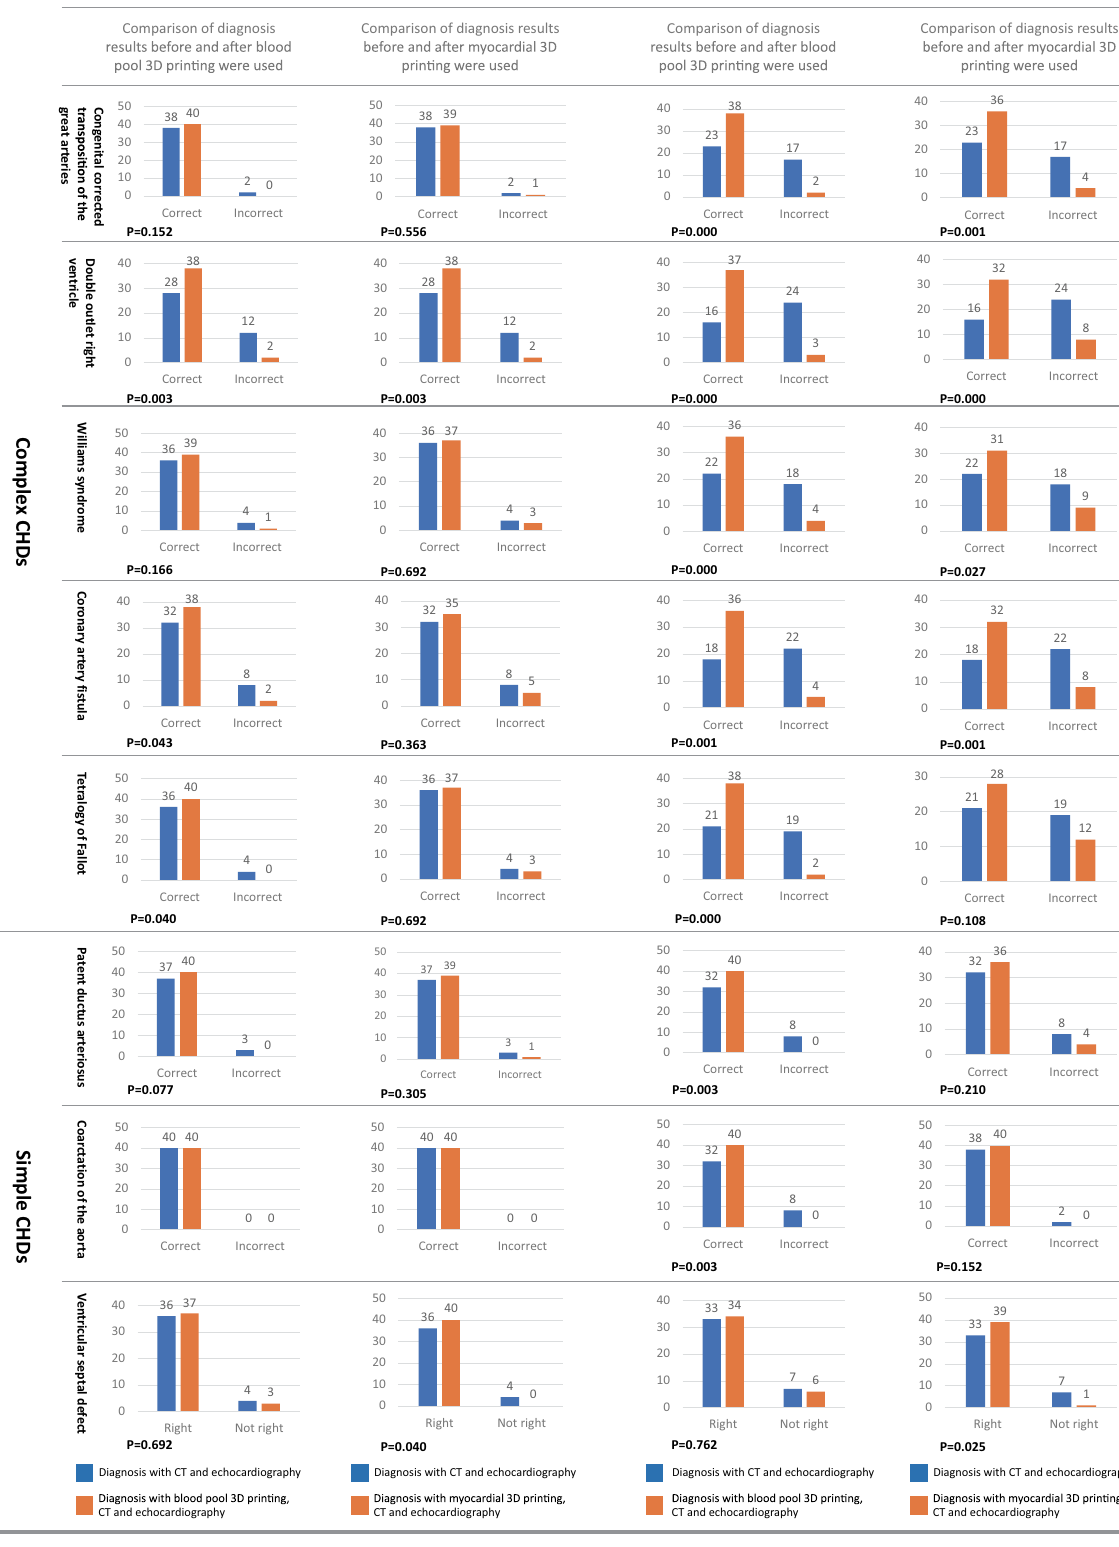
Figure 3. Comparison of diagnosis results before and after blood pool or myocardial 3D printing was used. The correctness of diagnosis results with CT and echocardiography, with blood pool 3D prints and echocardiography, and with myocardial 3D prints and echocardiography were compared